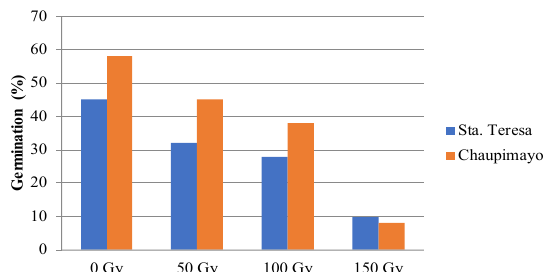
Figure 3. Percentage of germination of coffee ( Coffea arabica L. var. typica) seeds originating from Santa Teresa and Chaupimayo under laboratory conditions at 84 days after sowing following irradiation with gamma rays at 0 (control), 50, 100, and 150 Gy.